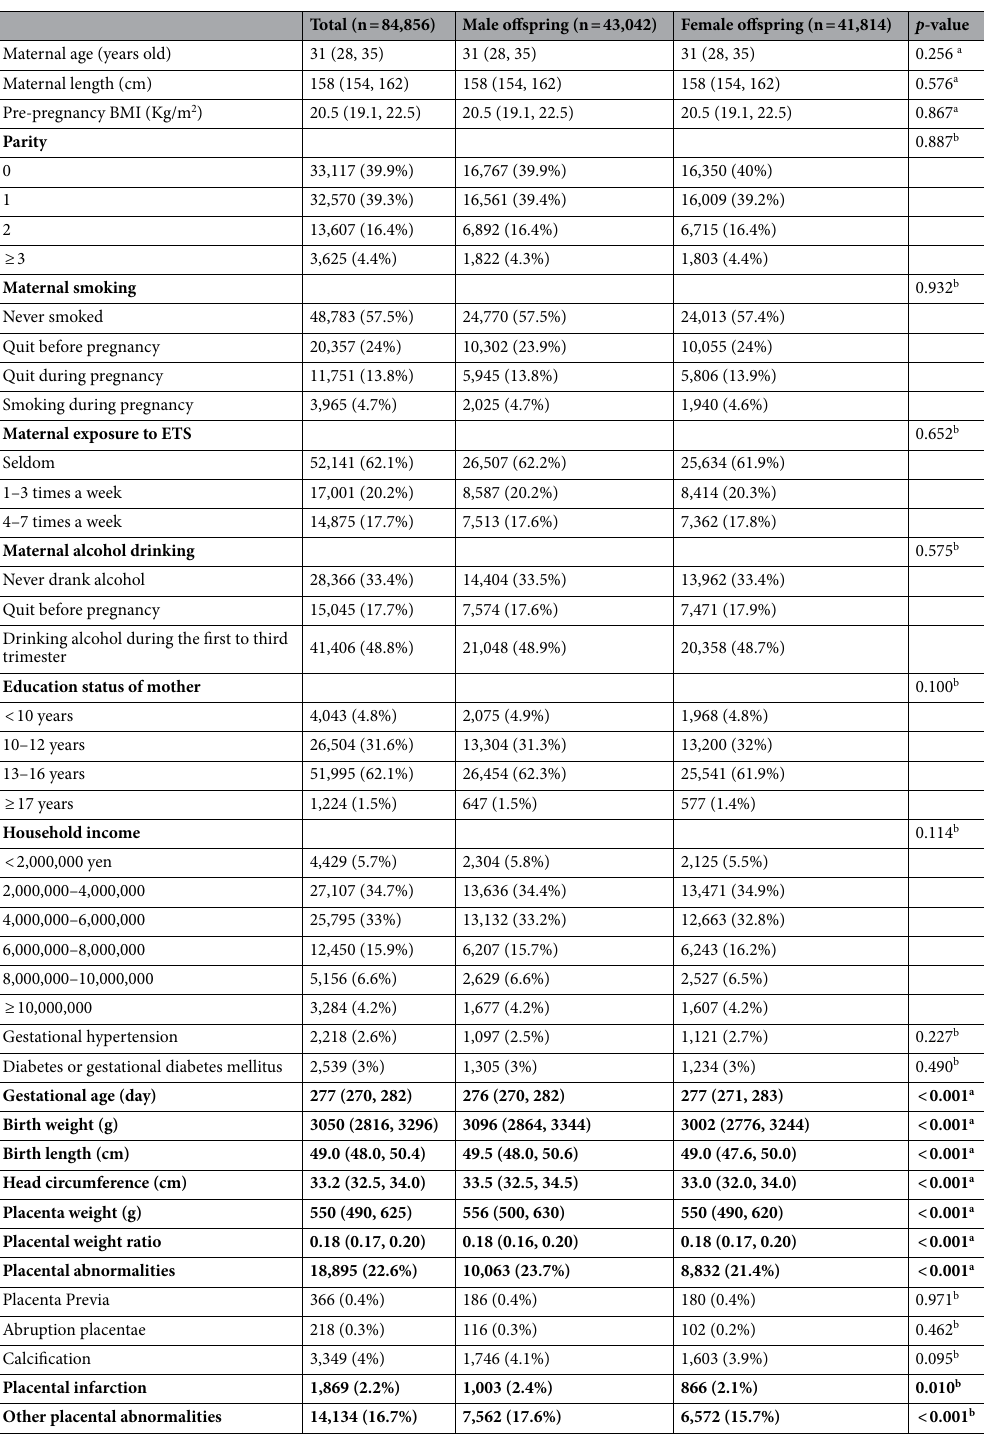
Table 1. Clinical and social characteristics of participants. a Mann–Whitney U Test, b chi-square test. The values are shown as median (IQR) for continuous variables or the number (percent) for nominal variables. Bold numbers indicate values with statistical